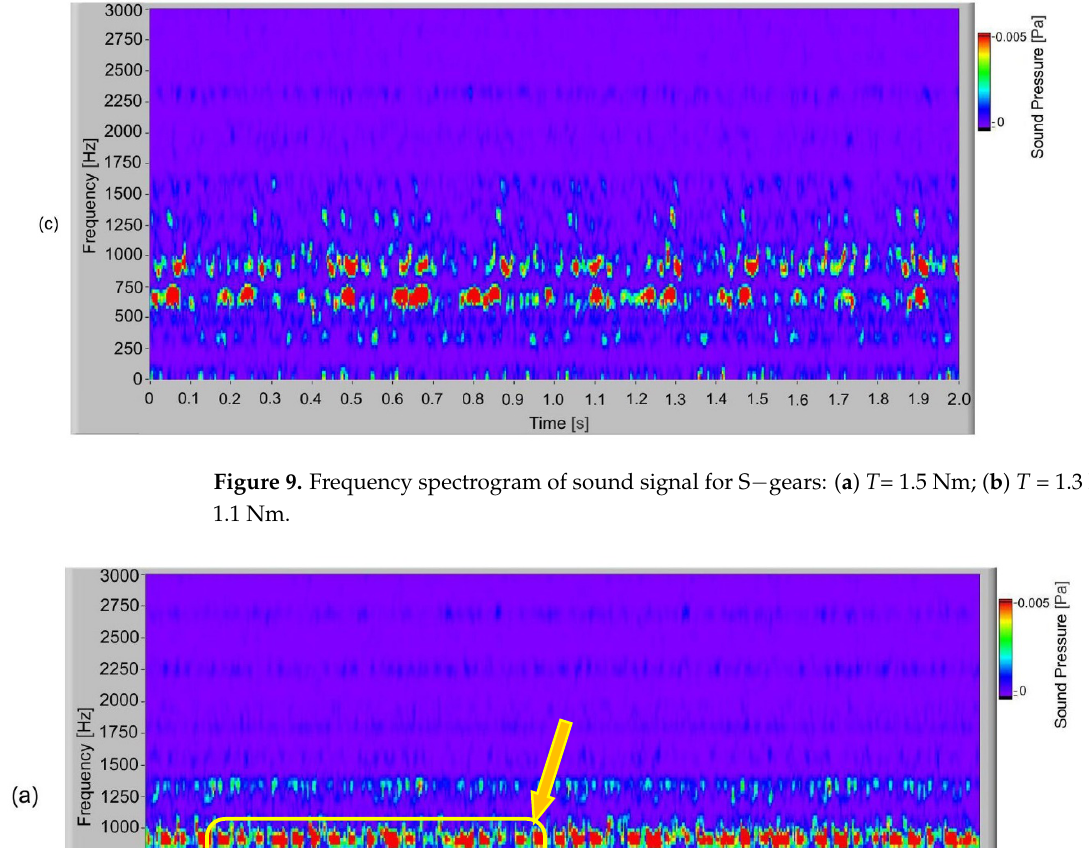
Figure 10. Frequency spectrogram of sound signal for E-gears: ( a ) T = 1.5 Nm ; ( b ) T = 1.3 Nm ; ( c ) T = 1.1 Nm. If, in the frequency spectrum, the influence of roughness and friction is observed, the presence of pulsation in time–space in many typical frequency components is observed in the spectrogram. The intensity of pulsation is connected with friction, because the effect of moving and stopping the tooth flank on the surface contact, i.e., the slip-stick effect, is dominant over roughness as the quality of tooth is relatively good and the gear pair op- erates with normal test parameters.